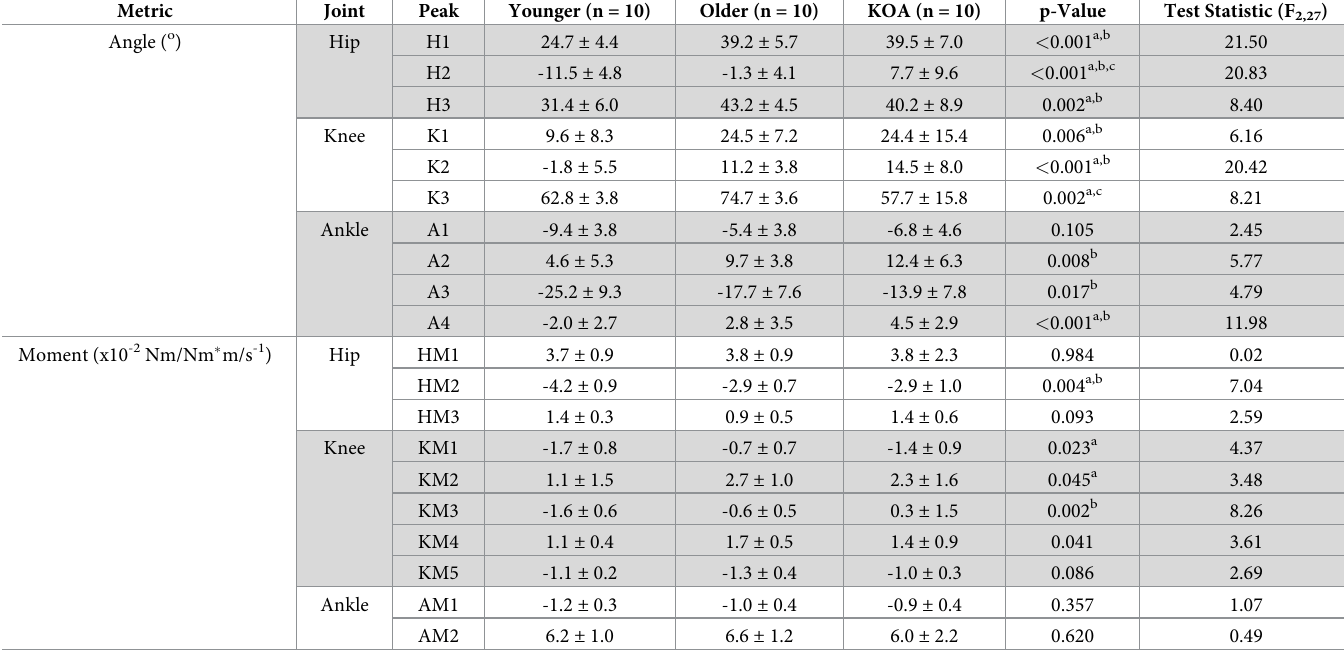
Peak joint angles and moments reported in the table as the average ± standard deviation. Hip flexion, knee flexion, and ankle dorsiflexion angles are positive. Hip extension, knee extension, and ankle plantarflexion moments are positive and were normalized to body mass, height, and walking speed. Superscripted letters indicate pairwise differences between a Younger and